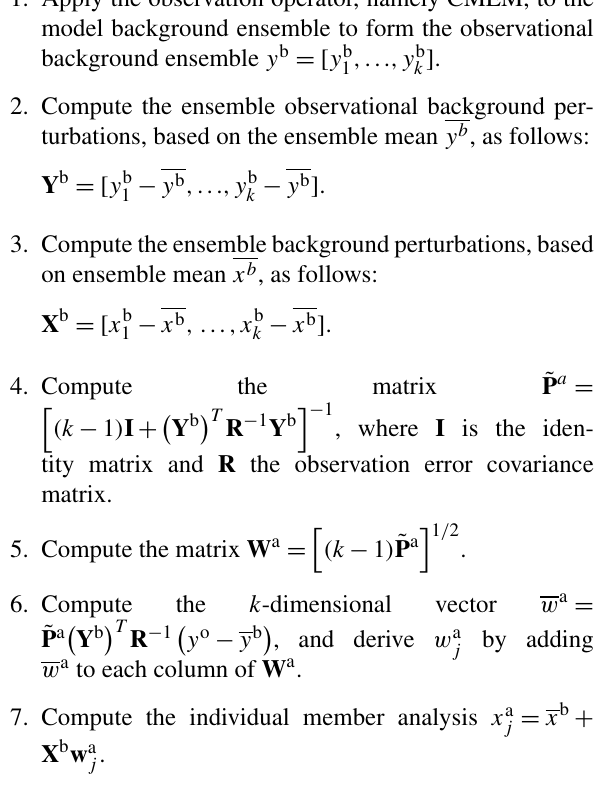
Table 1. Main processes implemented in the CLM- and SFX-based studies. Main processes CLM SFX Radiative fluxes Solar and long-wave radiations Evaporation and